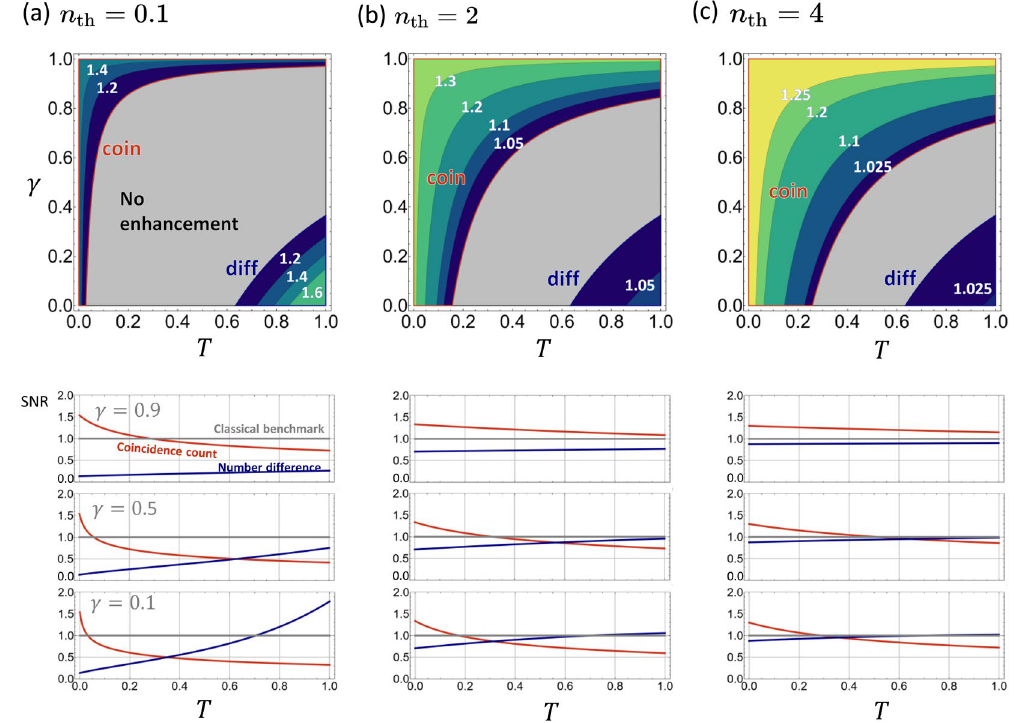
Figure 6. Quantum enhancement achieved by the TMSV state as quantified by R κ in the new quantum setup. The regions are labeled in the same way as in Fig. 3. Note the diminished quantum enhancement compared to Fig.